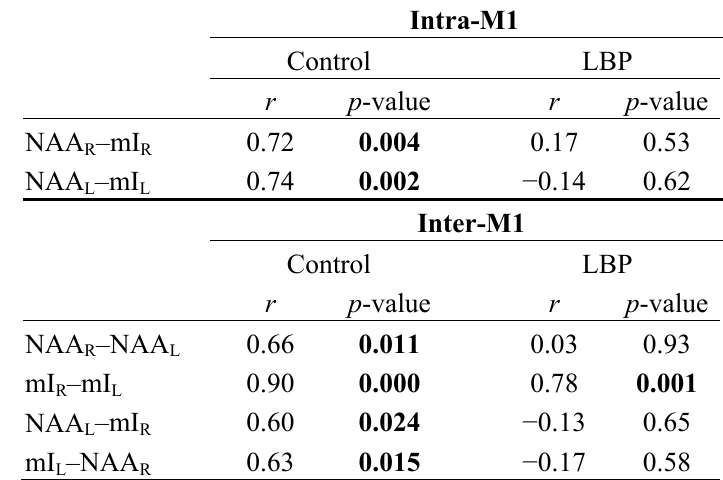
Table 2. Correlation between N -acetylaspartate (NAA) and myo-inositol (mI) within (intra-M1) and between (inter-M1) in control and low back pain (LBP)